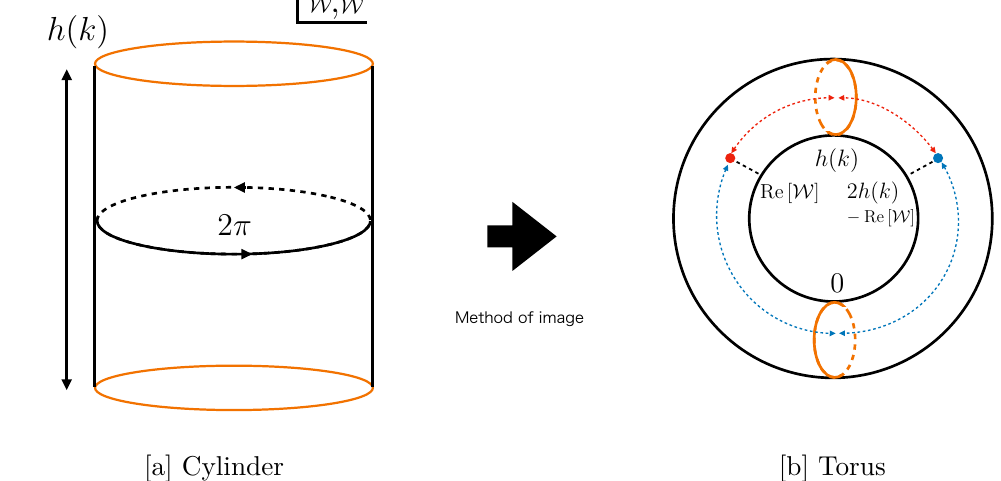
[b] Plane Figure 1: Left panel: A cartoon of the thermal cylinder with two cuts. In this figure, red and blue lines correspond to the subsystems A and B , respectively. The orange lines illustrate the cuts corresponding to the projection measurement. Right panel: A cartoon of projection measurement on the plane. In this panel, we show the location of only projection measurement. The parameter k is defined by (1.17)